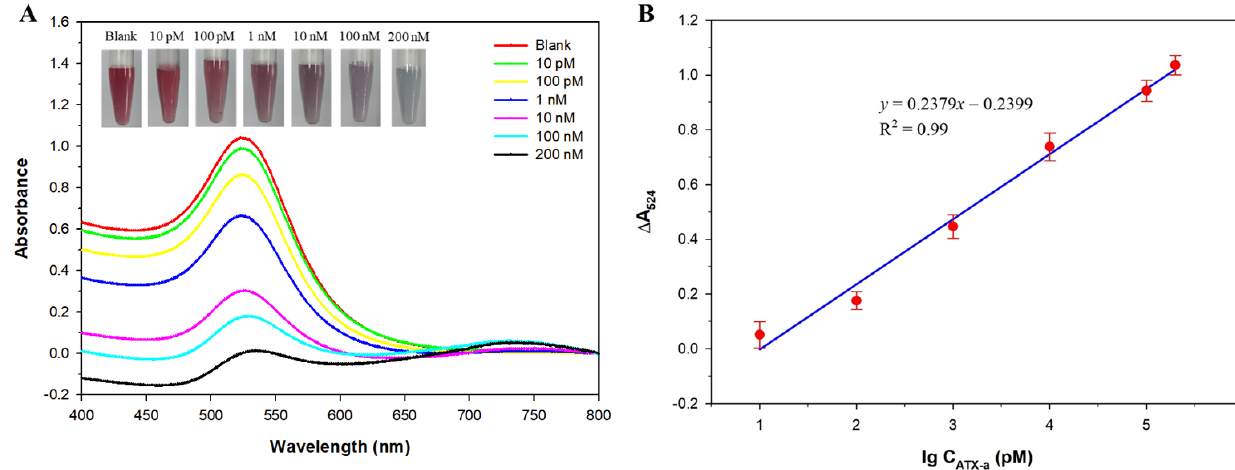
Figure 6. ( A ) The UV/Vis absorption spectra of the gold nanoparticle (AuNP) solutions in the presence of mixtures of 125 nM aptamer and various concentrations of anatoxin-a (ATX-a) after incubation with 40 mM NaCl for 5 min (inset: visible color changes of AuNP solutions). ( B ) Derived calibration curve showing the variation of relative absorbance at 524 nm ( Δ A 524 ) versus the logarithmic concentration of ATX-a. Table 1. Comparison with reported methods for anatoxin-a detection.